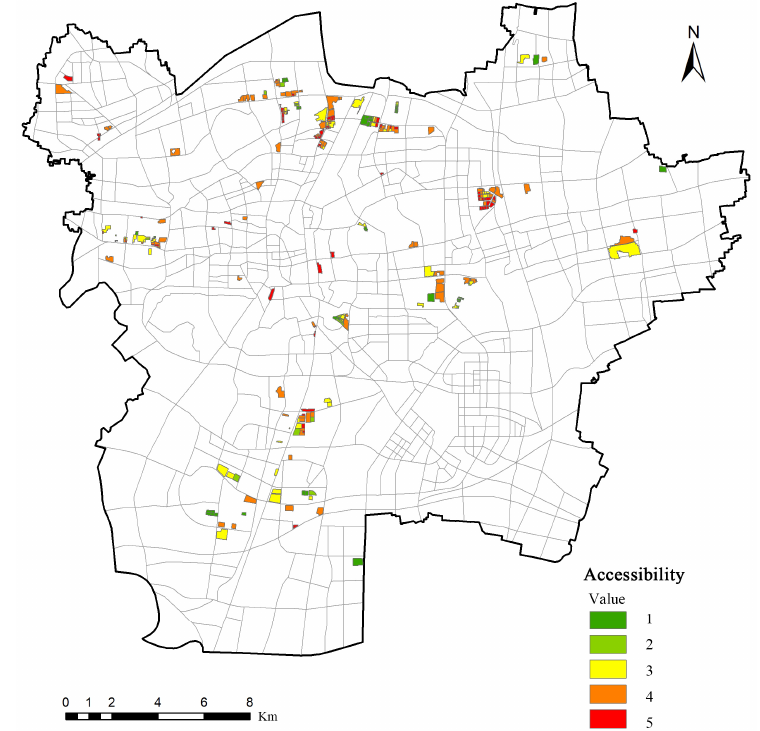
Figure A5. Single value of site suitability based on “Accessibility”.